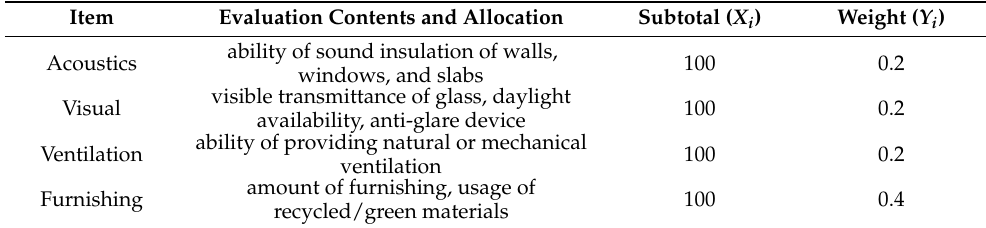
Table 4. Evaluation contents for IEQ in EEWH with rating scores and